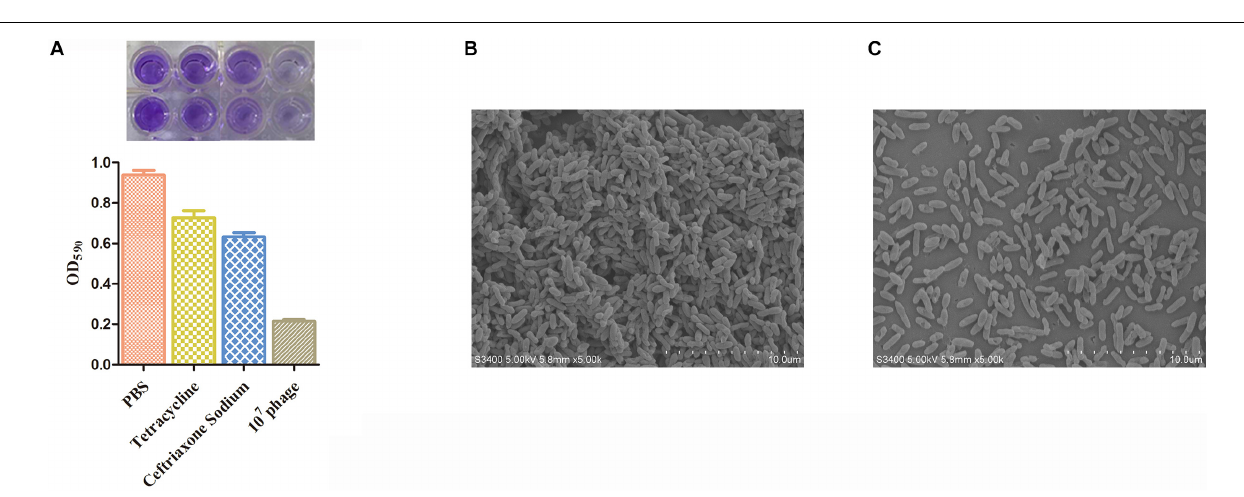
FIGURE 4 | The bactericidal activity of IME-JL8 to C. freundii CF8. The CFU/mL decrease of the C. freundii CF8 culture was adopted to assess the bactericidal activity of IME-JL8. A final bacterial ( C. freundii CF8) count of 10 8 CFU/mL and phage IME-JL8 was added at a MOI of 0.01 in the tubes. The bacterial administrated with PBS as control. Each data is expressed as mean ± SD from three biological experiments.